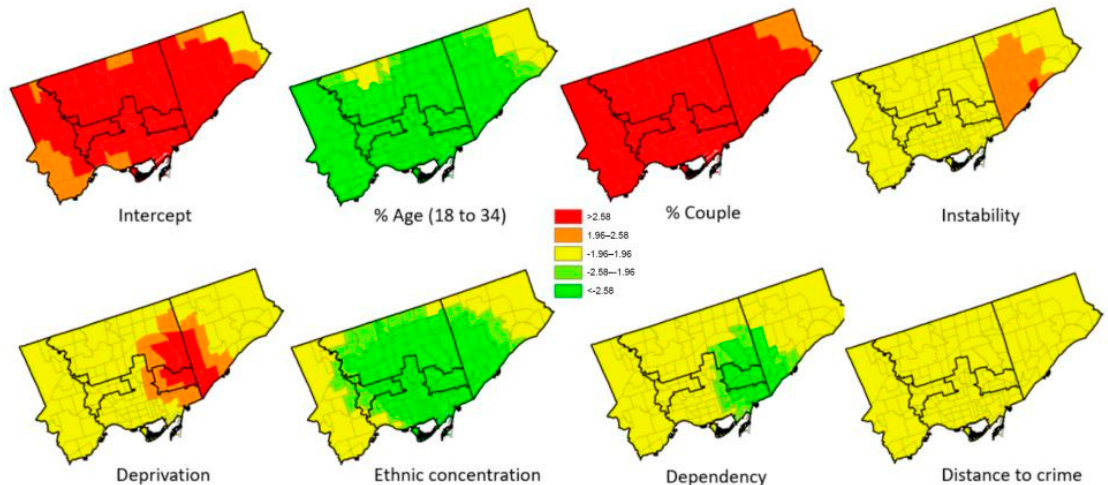
Figure 4. Pseudo t -values for intercept and independent variables.